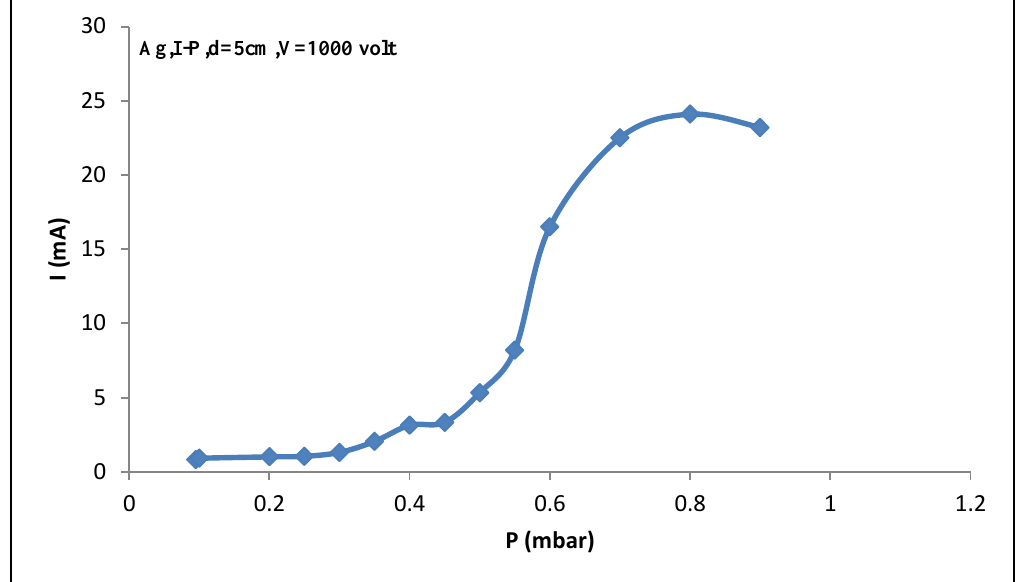
Fig. 4: The variation of discharge current with different working pressures for silver